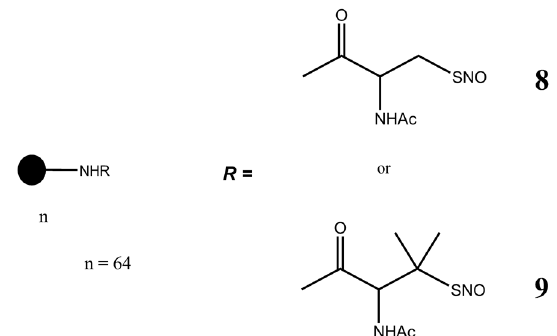
FIGURE 4 - Representation of PAMAM dendrimer with S -nitrosothiols (adapted from Stasko, Fischer, Schoenfisch, 2008).